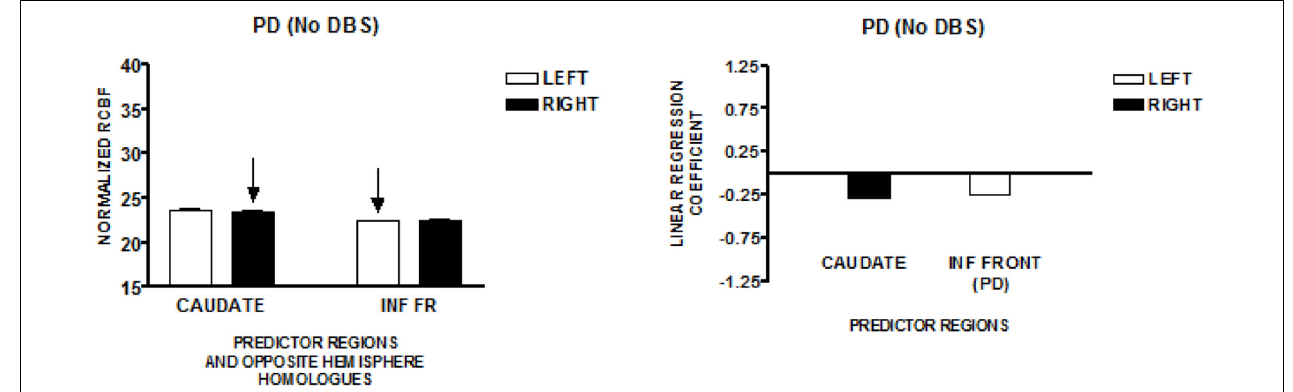
FIGURE 4 | The results from a speech production study in individuals with Parkinson’s disease using the same protocol employed in the study of normal volunteers in New York (NY). Their Parkinson’s disease was treated pharmacologically without deep brain stimulation (DBS). The graph on the left presents the mean normalized CBF ( ± SEM) for the head of the caudate nuclei, and the inferior frontal region, bilaterally. The graph on the right presents the linear regression weights for the two predictor regions (Sidtis et al., 2021). The negatively weighted left inferior frontal region is adjacent and inferior to the left inferior predictor region in the NY normal group.